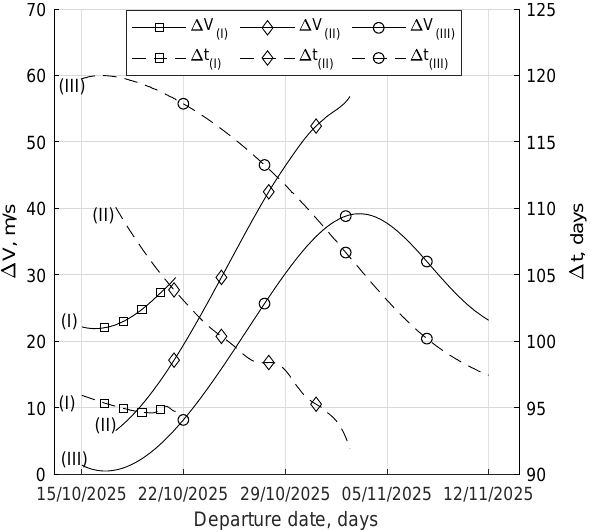
Figure 10. Influence of departure date to escape from SEL2—families of solutions—fixed C 3 = 0.2 (km/s) 2 , free t f .